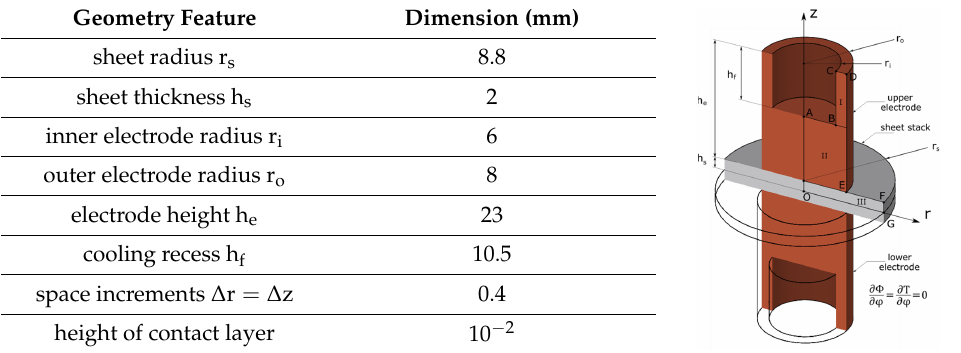
Table 1. Geometry features and dimensions.